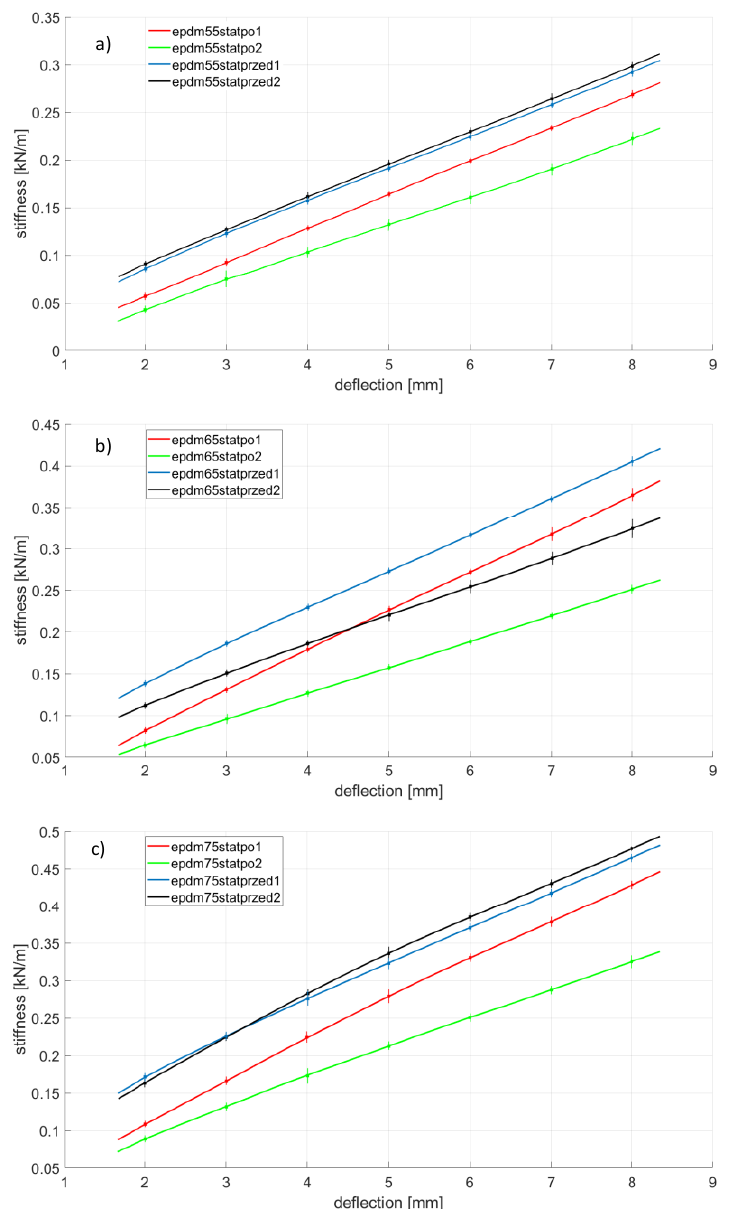
Figure 9. EPDM rubber changes of stiffness during various tests conducted on the tensile machine, ( a ) — EPDM 55 Sh A, ( b ) — EPDM 65 Sh A, ( c ) — EPDM 75 Sh A.